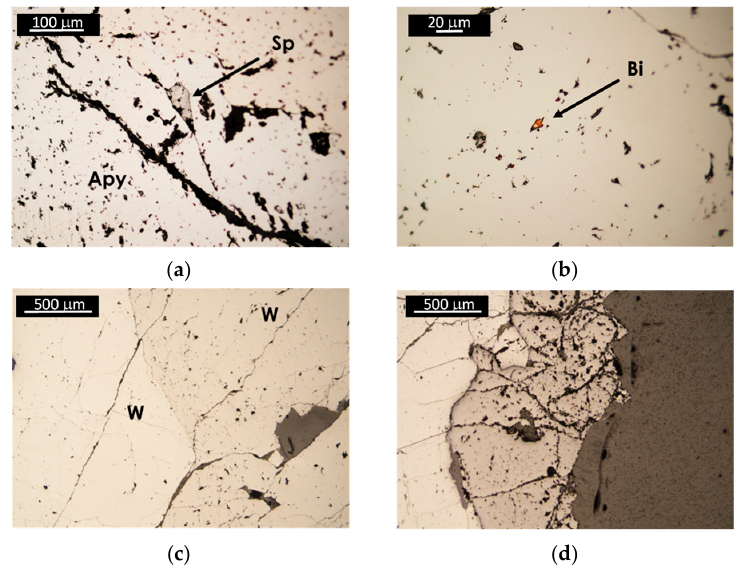
Figure 4. Photomicrographs of mineralized samples: ( a ) wolframite crystal; ( b ) wolframite and cassiterite crystals; ( c ) arsenopyrite and sphalerite crystals; ( d ) arsenopyrite and native bismuth. All photomicrographs were taken in reflected and plane-polarized light. W—wolframite, Sn—cassiterite, Apy—arsenopyrite, Sp—sphalerite, Bi—native bismuth.